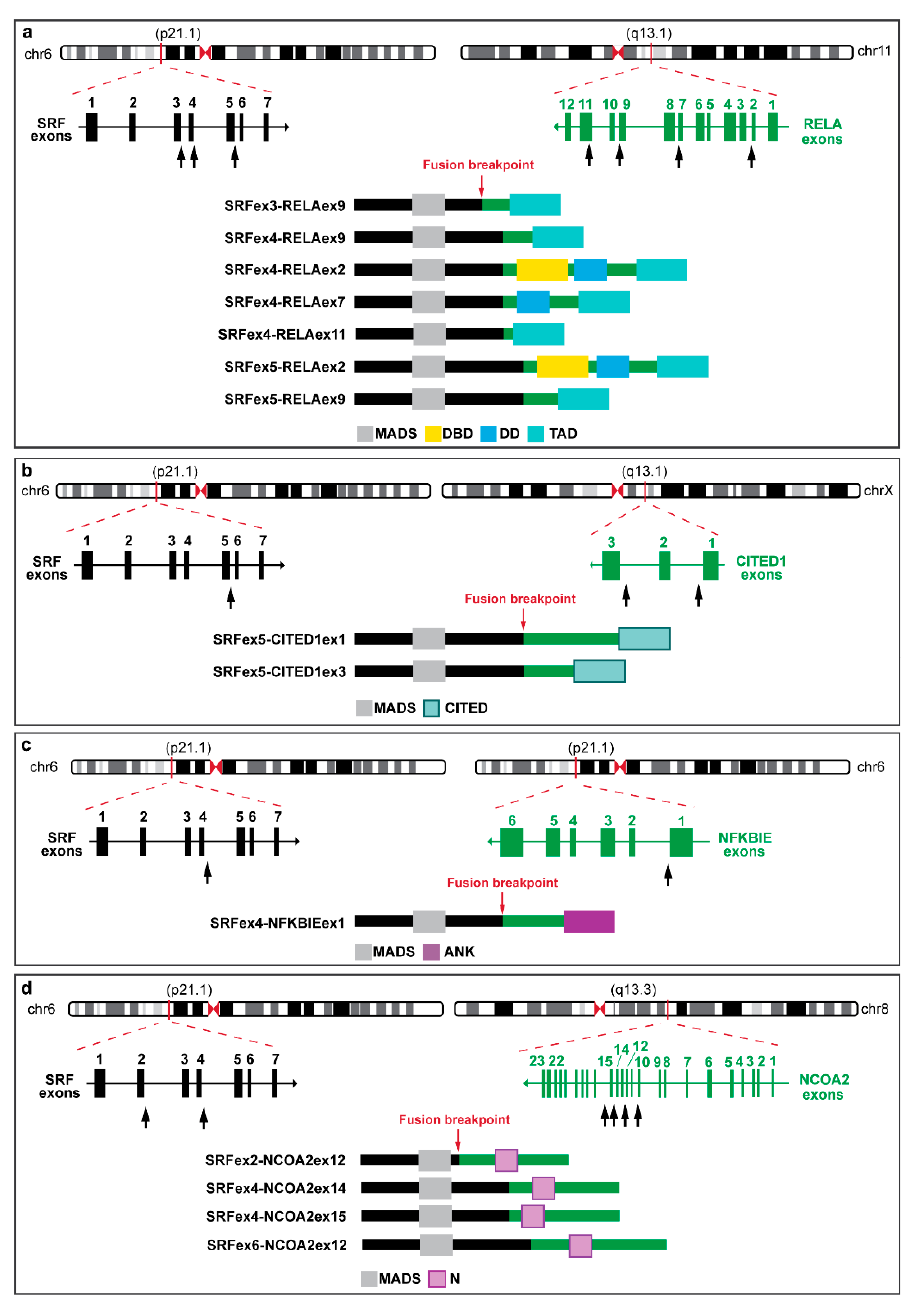
Figure 6. Schematic representation of SRF fusion transcripts and predicted chimeric proteins, de- picting the exons and protein domains involved. The genomic exon structure of SRF and fusion partner genes is reported on the left and on the right, respectively: SRF::RELA ( a ) [4–6], SRF::CITED1 ( b ) [5, 9], SRF::NFKBIE ( c ) and SRF::NCOA2 ( d ) [5, 23, 24]. Black arrows indicate breakpoints. Resulting chimeric proteins for each fusion transcript are reported at the bottom of each figure. MADS: MAD box DNA binding domain; DBD: DNA binding domain; DD: dimerization domain; TAD: transactivation domain; CITED: CBP/p300-interacting transactivator with ED-rich tail domain; ANK: ankyrin repeats and N: nuclear receptor coactivator.